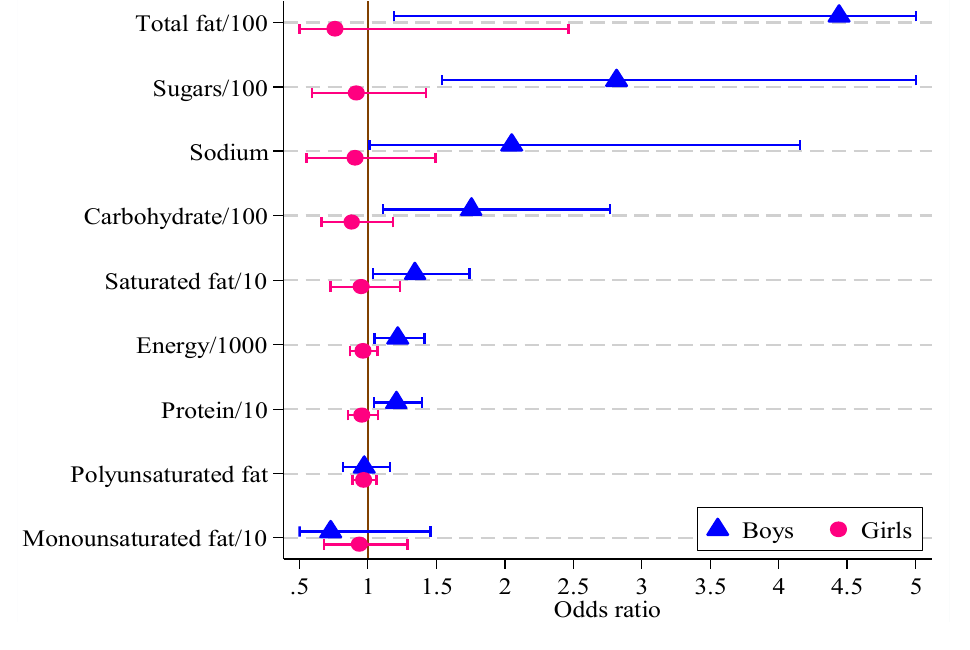
Figure 2. Odds ratios, with 95% confidence intervals, for boys and girls from multivariate logistic regression models of CVD risk score on diet measure (boys, n = 121; girls, n =